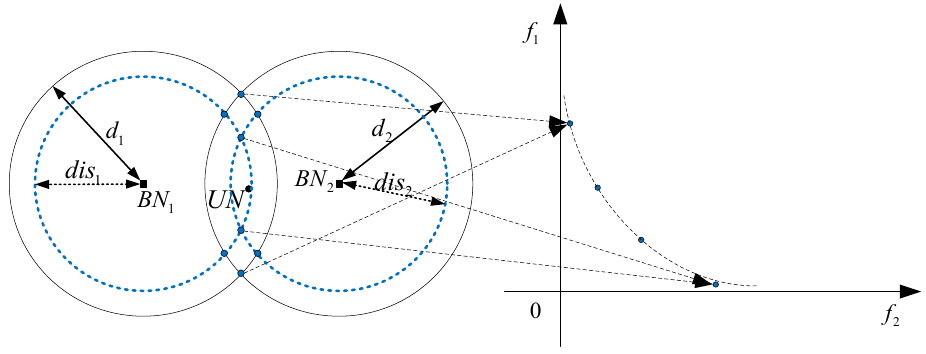
Figure 5. Multi-objective constraint principle.